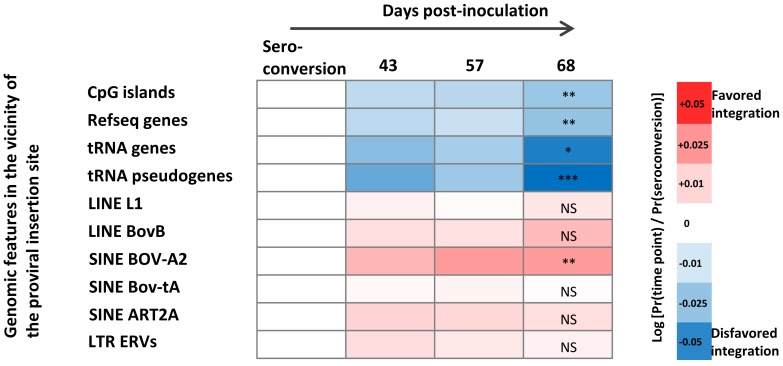
Evolution of provirus environment during primary infection.Genomic heat map of integration preferences compared to the distribution observed at the time of seronconversion. Genomic features analyzed are shown to the left of the heat map. Gene and CpG proximity was calculated with a genomic interval of 50-values are calculated by Chi-squared test for trend and show significance of the increasing or decreasing trend from the seroconversion date to day 68 post-inoculation. Data are representative for the all 5 animals.